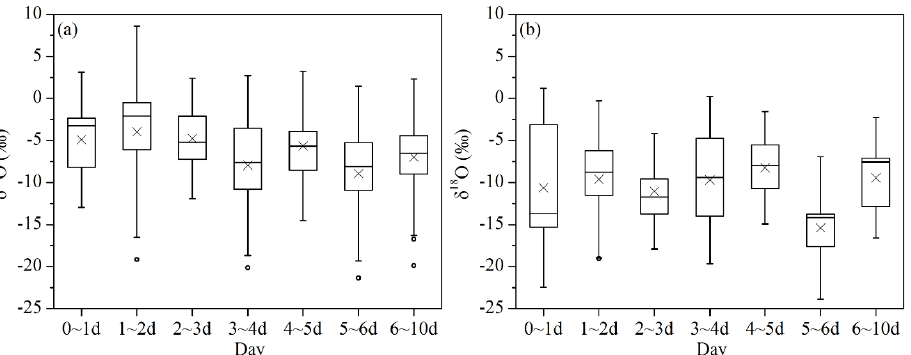
Figure 8. The relationship between the backward trajectory backtracking time and δ 18 O in precipitation at Minxian Station in the summer half-year ( a ) and winter half-year ( b ), the top and bottom of the box are the 25th and 75th percentiles, and the line near the middle of the box is the median, the cross is the mean, the black dots are outliers, and the whiskers are the mean plus or minus 2 standard deviations.